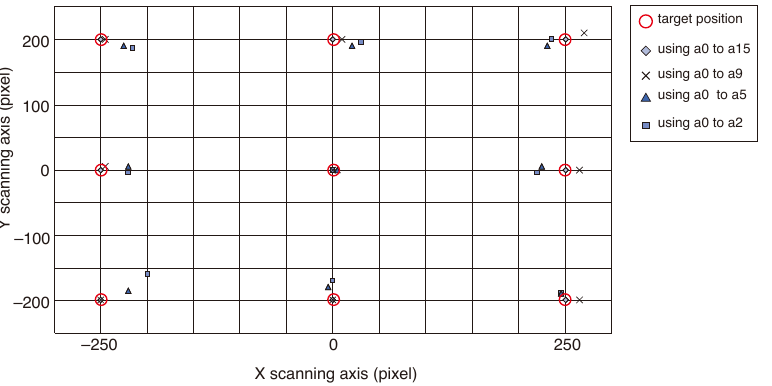
Figure 2. The result of the correction for distortions in the scanning optical tweezer system. The errors pertaining to the target focus positions are indicated by four symbols under a five-times-expanded scale. The number of measured data points is N = 119. The 512 × 440 pixel imaging plane is equivalent to the 138 × 118 µ m real workspace for × 40 objective lens, the 92 × 79 µ m for × 60, and the 54 × 47 µ m for × 100,